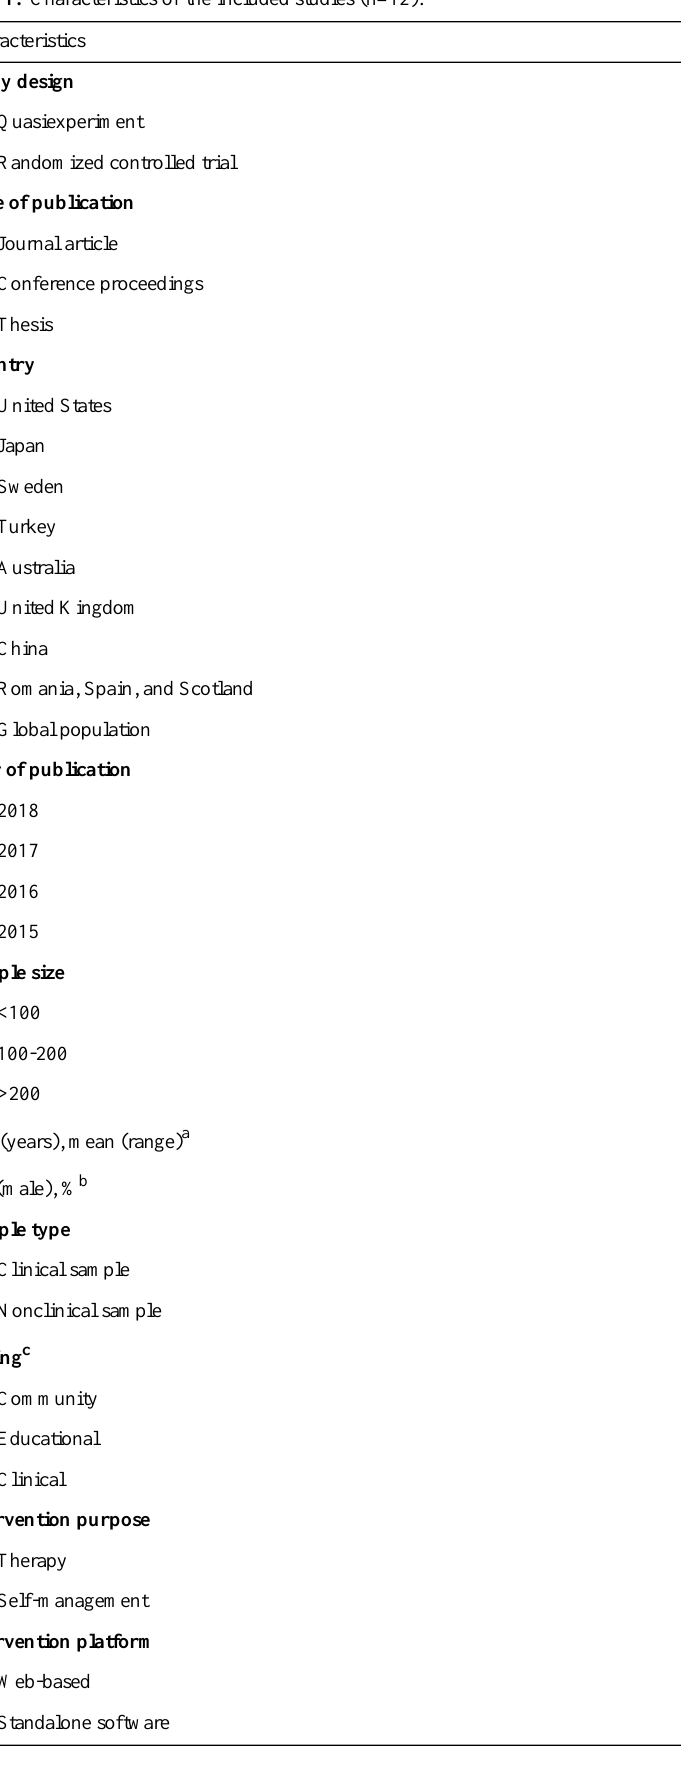
Table 1. Characteristics of the included studies (n=12).